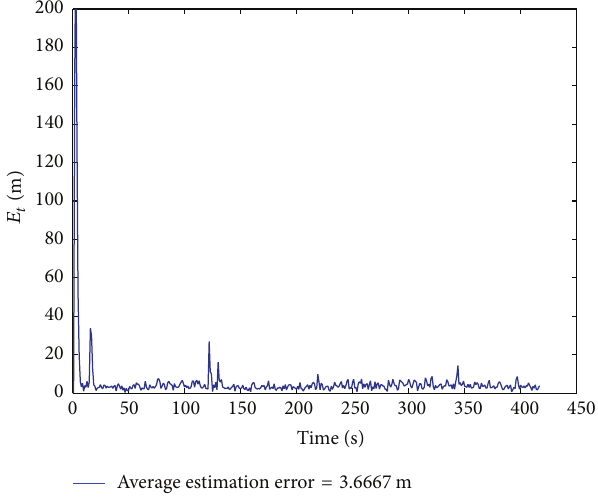
Average estimation error = 3.6667 m Figure 26: Estimation error of GA based adaptive 𝛼 - 𝛽 - 𝛾